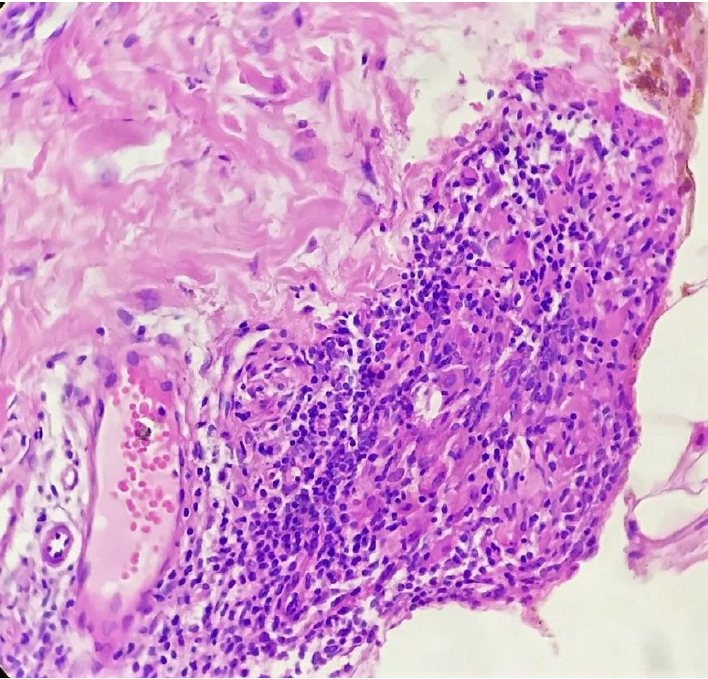
Figure 5. Compact tuberculoid granuloma in deep dermis (H&E × 400).